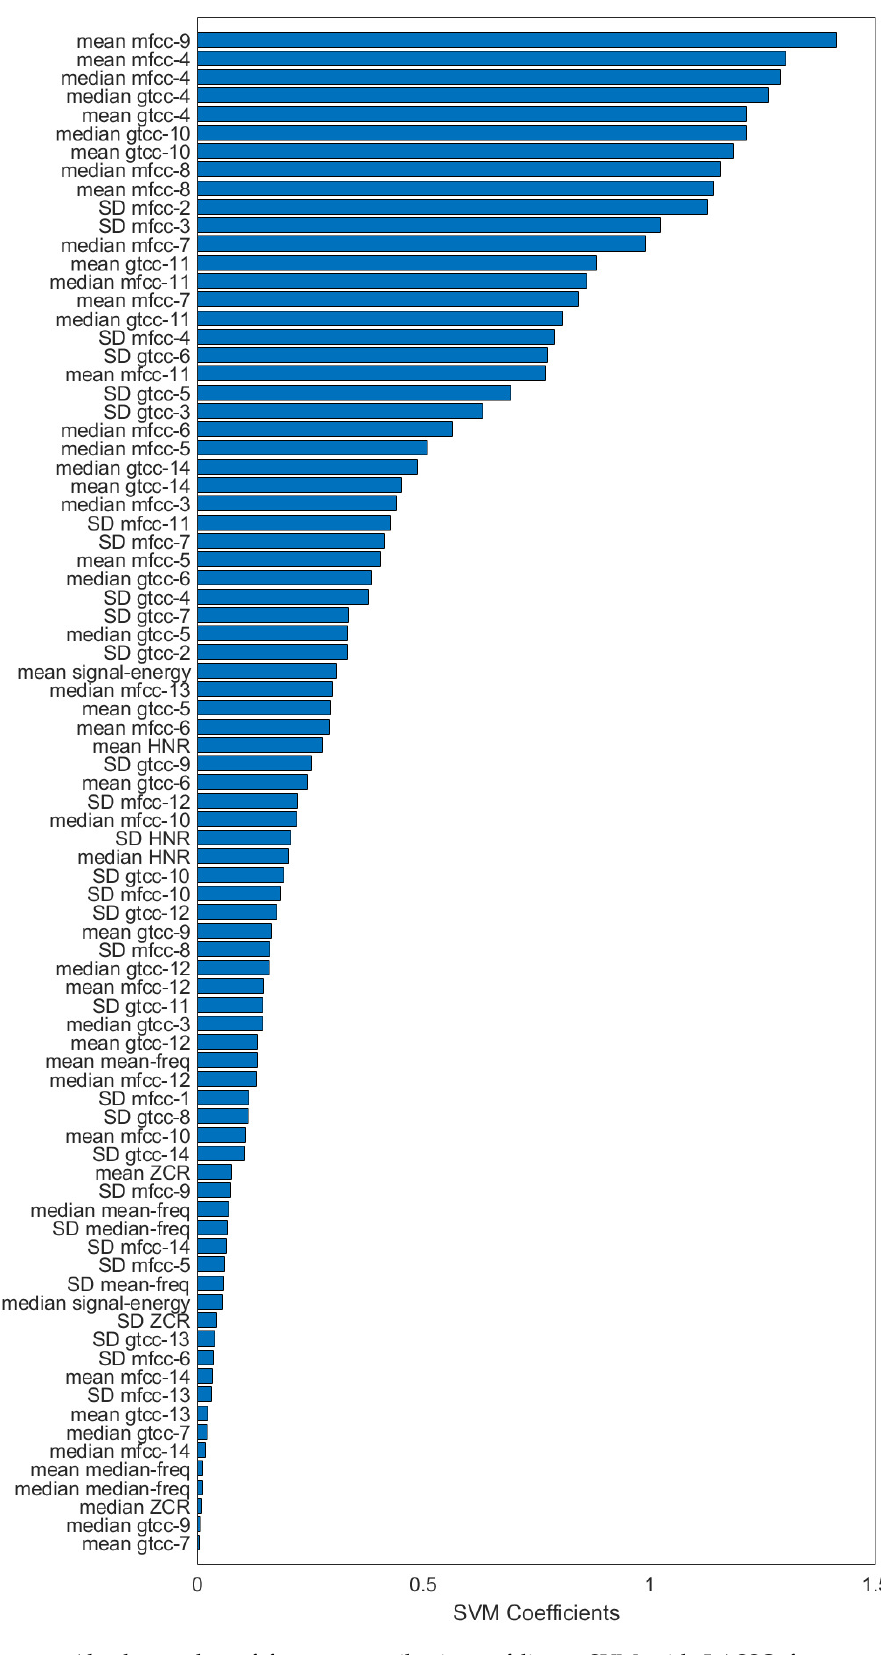
Figure 6. Absolute value of feature contributions of linear SVM with LASSO feature selection, sorted